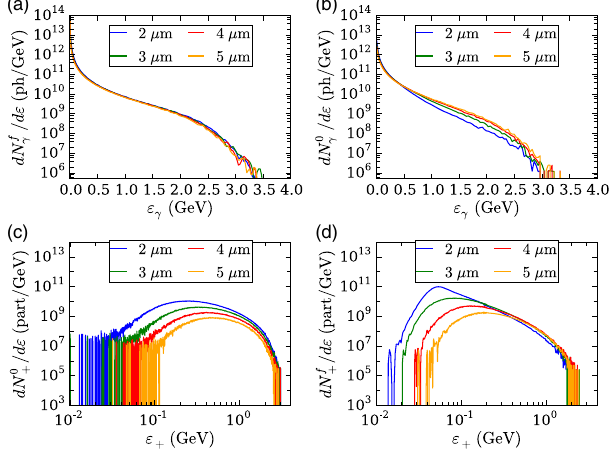
FIG. 11. (a,b) Photon energy distributions (in photons per GeV) at creation time, dN 0 γ =d ε (a) and at the end of the interaction, dN f γ =d ε (b), for various laser spot sizes (or, equivalently, intensities). (c,d) Positron energy distributions (in particles per GeV) at creation time, dN 0 þ =d ε (c) and at the end of the interaction, dN f þ =d ε (d), for various spot